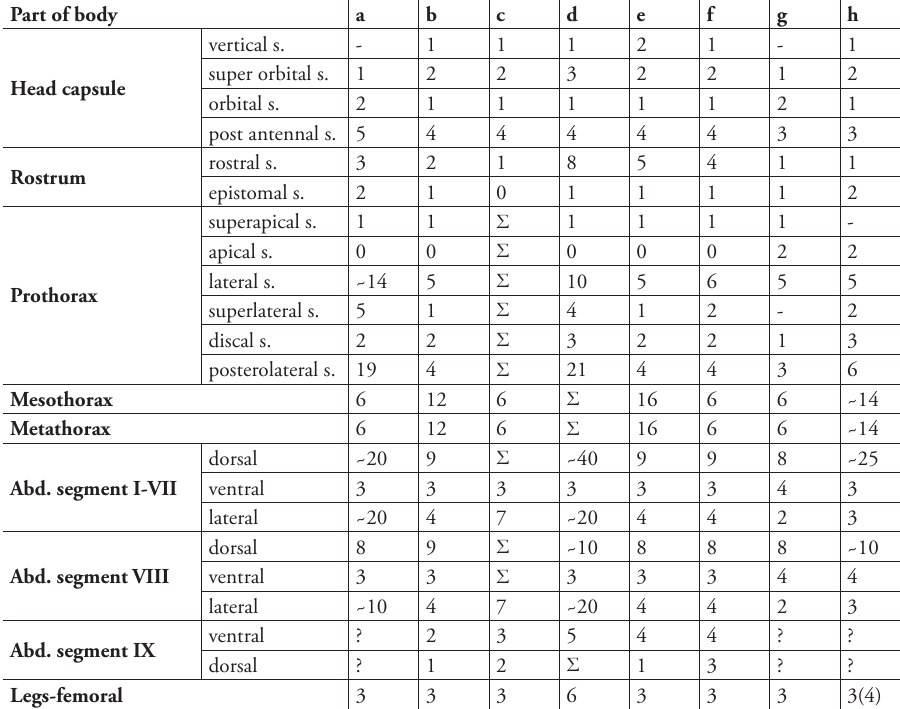
Table 2. Pupal setal index of selected Larinus species: (a) L. idoneus , (b) L. inaequalicolllis , (c) L. obtusus , (d) L. pollinis , (e) L. sibiricus , (f) L. sturnus , (g) L. turbinatus and (h) L. vulpes ( Σ – uncountable,